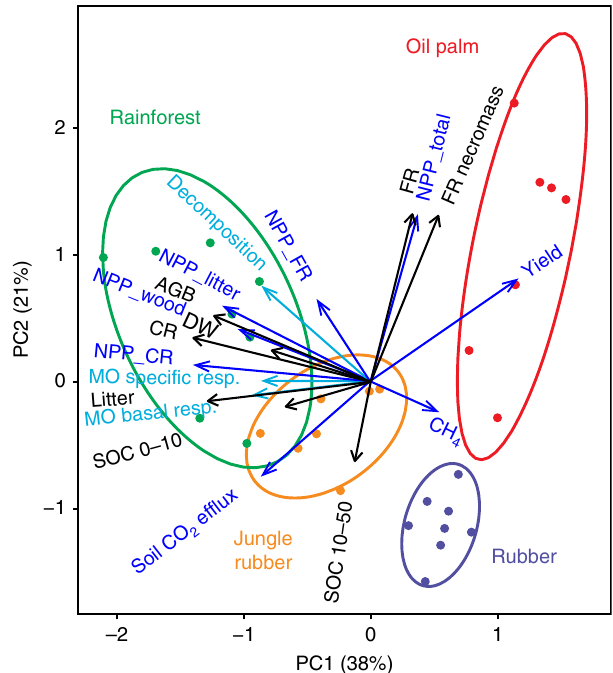
Fig. 5 Ordination of research sites by 19 variables in principal components analysis. Stocks are in black, fl uxes in dark blue, and decomposition processes in light blue. Abbreviations correspond to net primary production (NPP), aboveground biomass (AGB), coarse roots (CR), fi ne roots (FR), soil organic carbon between 0 – 10 cm depth (SOC 0 – 10) and 10 – 50 cm depth (SOC 10 – 50), methane uptake (CH 4 ), litterbag